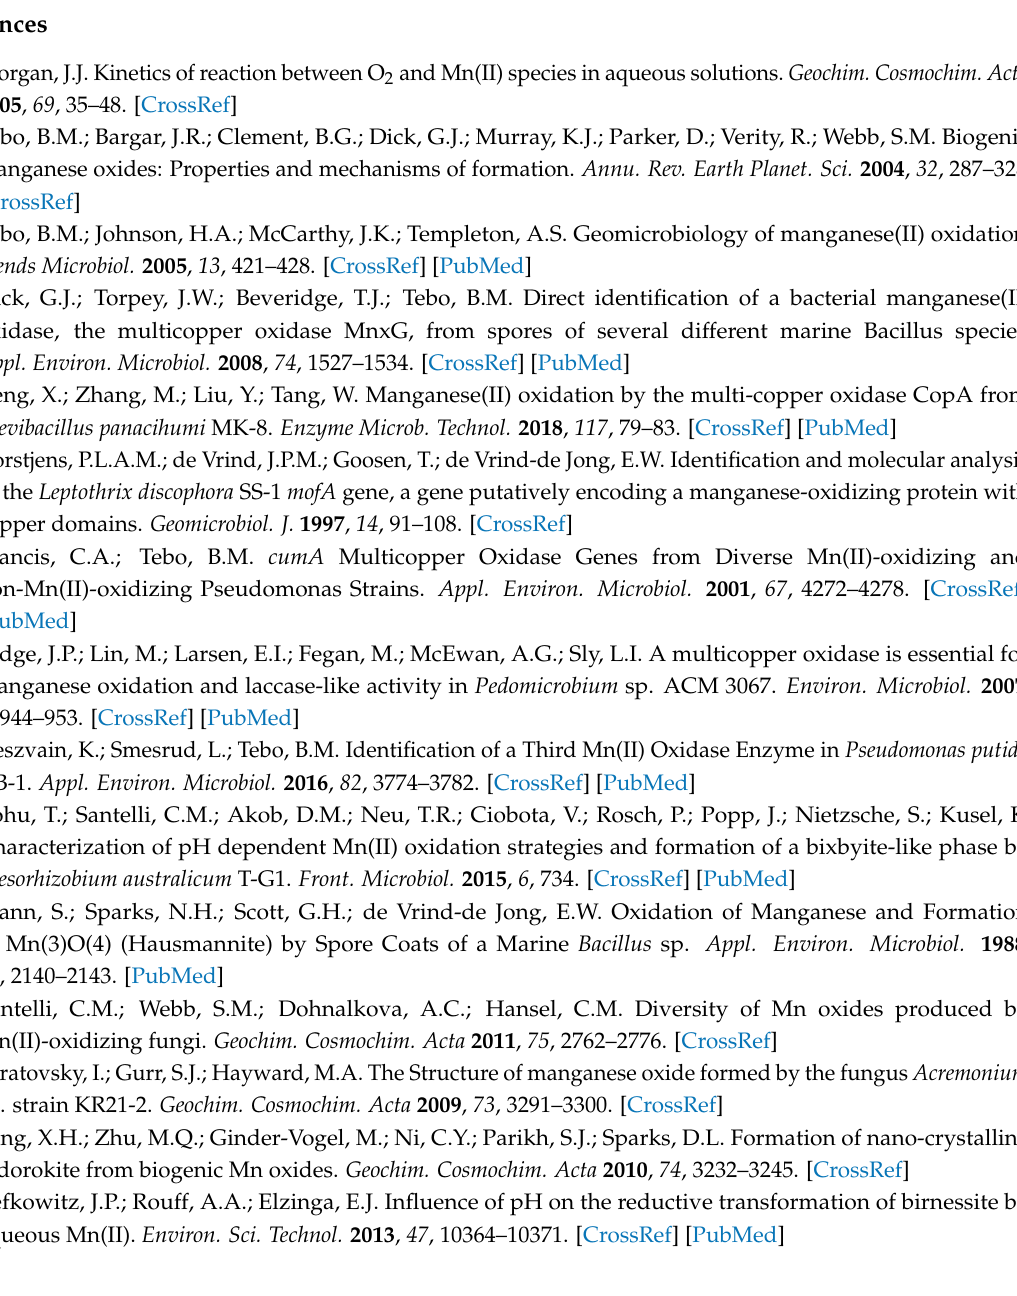
Figure S1: Bacterial community structure in Mn-deposits collected from the metal refinery wastewater pipe (full data). Table S1: NCBI accession numbers used to construct the phylogenetic tree in Figure 4. Table S2: Species names under the genera Hyphomicrobium , Magnetospirillum , Geobacter , Bacillus , and Pseudomonas detected in the bacterial community structure shown in Figure